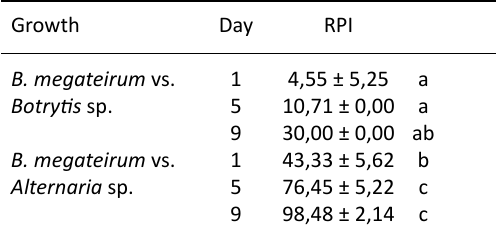
Table 1. Percentage of Radial Growth Inhibition